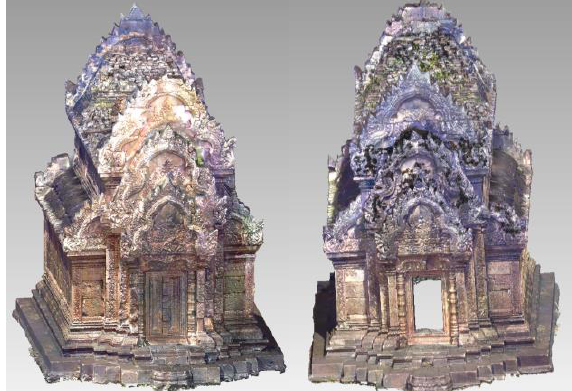
Figure 12. The final 3D model from different views